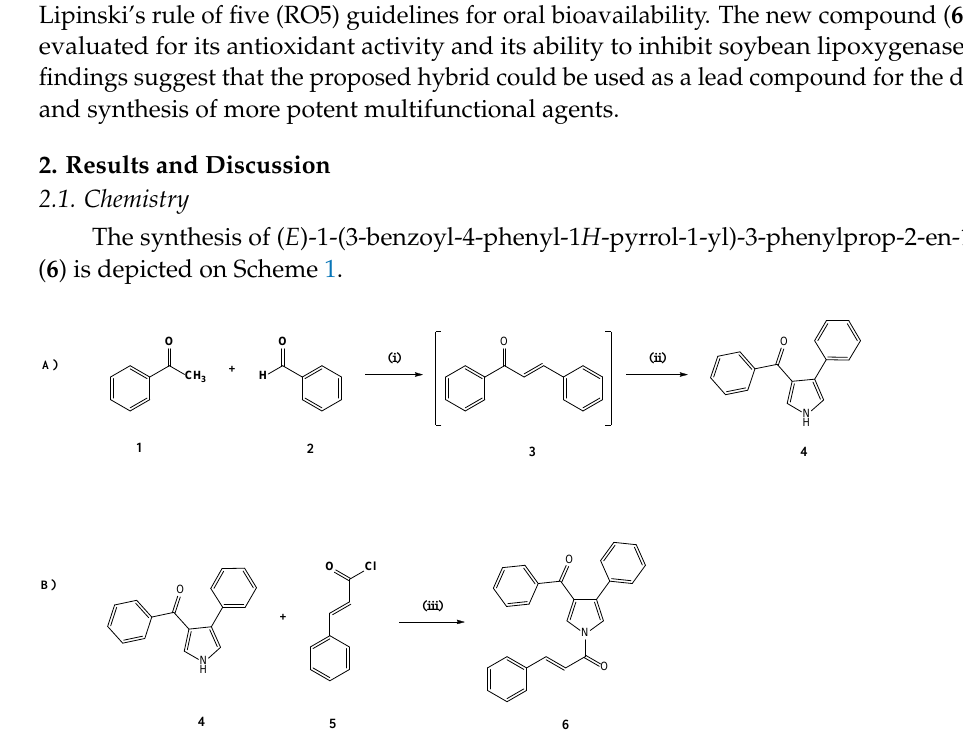
Scheme 1. ( A ) One-pot synthesis of phenyl(4-phenyl-1 H -pyrrol-3-yl)methanone ( 4 ). ( i ) LiOH.H 2 O, EtOH absolute, rt, 6 h. ( ii ) LiOH.H 2 O, p-toluenesulfonylmethyl isocyanide (TosMIC), rt, 17 h, yield